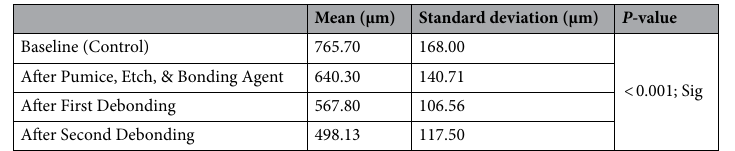
Table 1. Repeated measures ANOVA with post-hoc BONFERRONI test. Sig: Significant; NS: Not Significant.